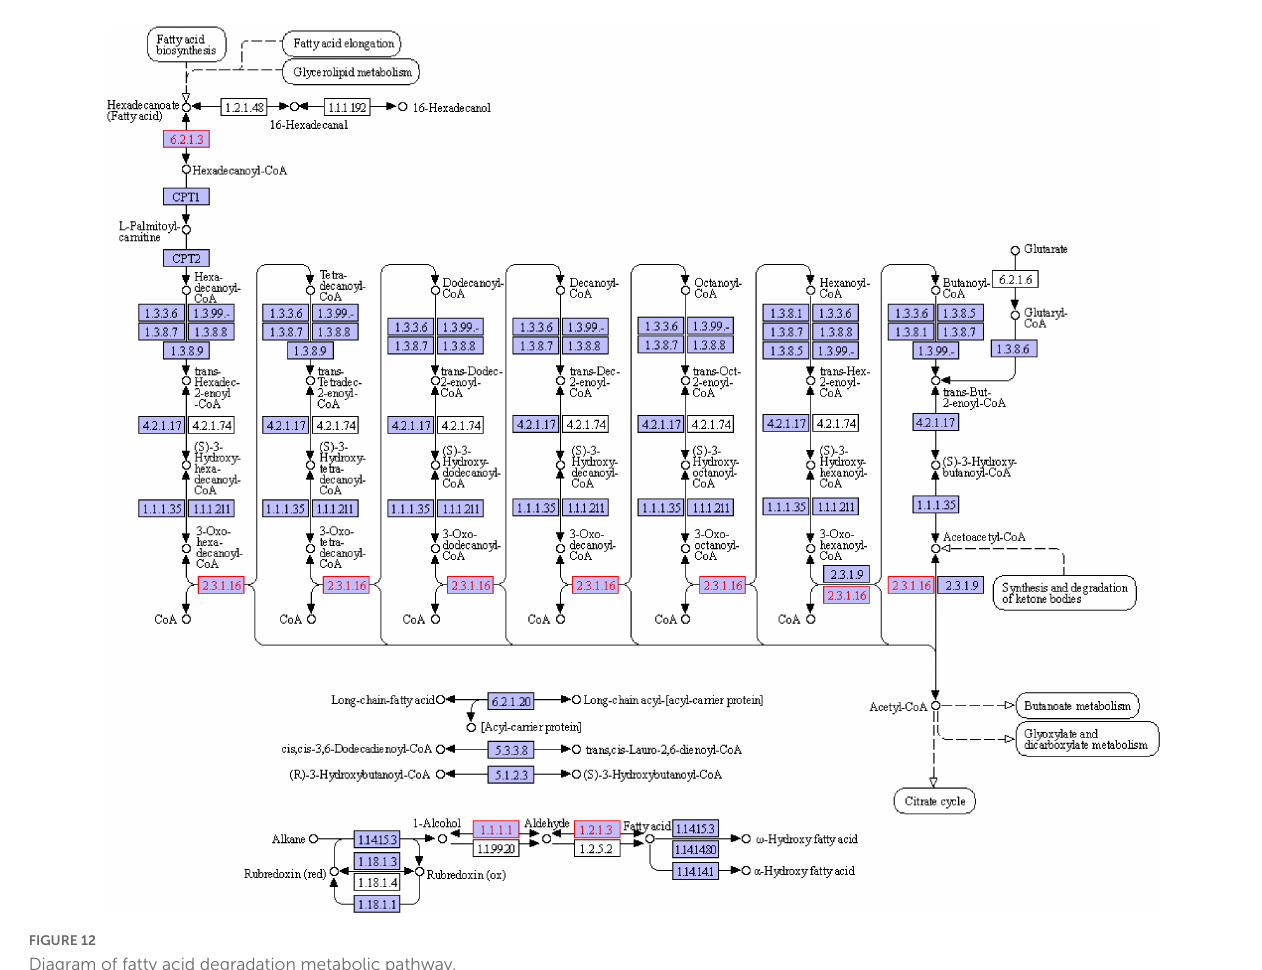
FIGURE12 Diagram of fatty acid degradation metabolic pathway.